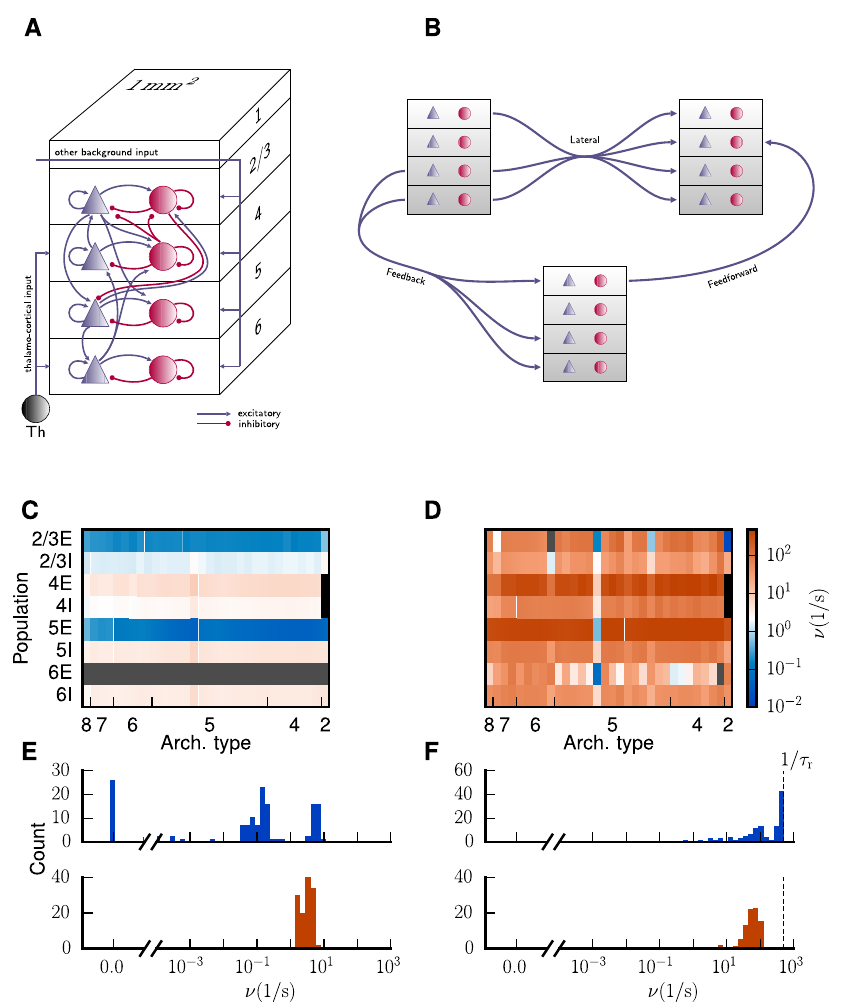
Fig 3. Bistability of the model. A Sketch of the microcircuitmodel serving as a prototype for the areas of the multi-areamodel (figure and legendadaptedfrom figure 1 of Potjans and Diesmann[23], with permission). B Sketch of the most common laminar patterns of cortico-cortical connectivity of the multi-areamodel. C Population-averaged firing rates encodedin color for a spiking network simulationof the multi-areamodel with low external drive ð k ¼ 1 : 0 Þ . D As C but for increasedexternal drive k ¼ 1 : 125 . The color bar refers to both panels.Areas are orderedaccordingto their architectural type along the horizontalaxis from V1 (type 8) to TH (type 2) and populationsare stacked along the vertical axis. The two missing populations 4E and 4I of area TH are marked in black and firing rates < 10 (cid:0) 2 Hz in gray. E Histogram of population-averaged firing rates shown in C for excitatory (blue) and inhibitory(red) populations. The horizontalaxis is split into linear-(left) and log- scaled (right) ranges. F as E correspondingto state shown in D.